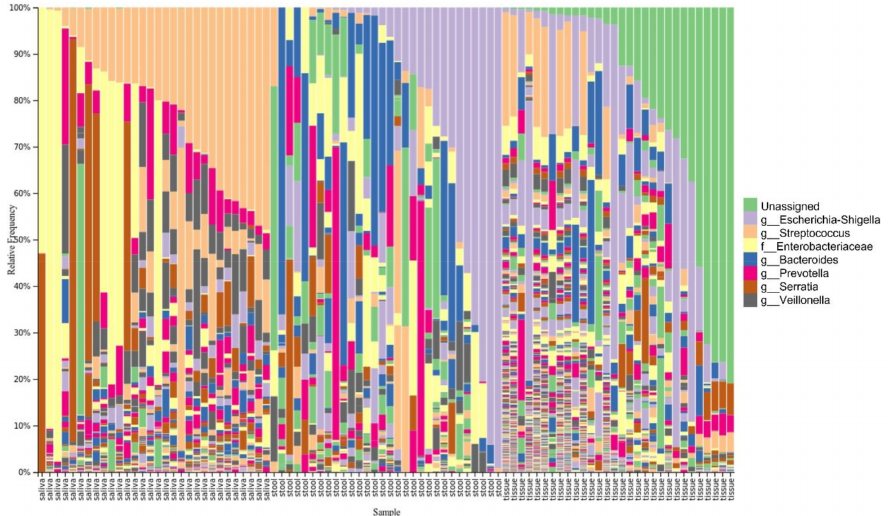
Figure 2. Taxonomy bar plot of the microbiome in the saliva, tissue, and stool samples of patients with